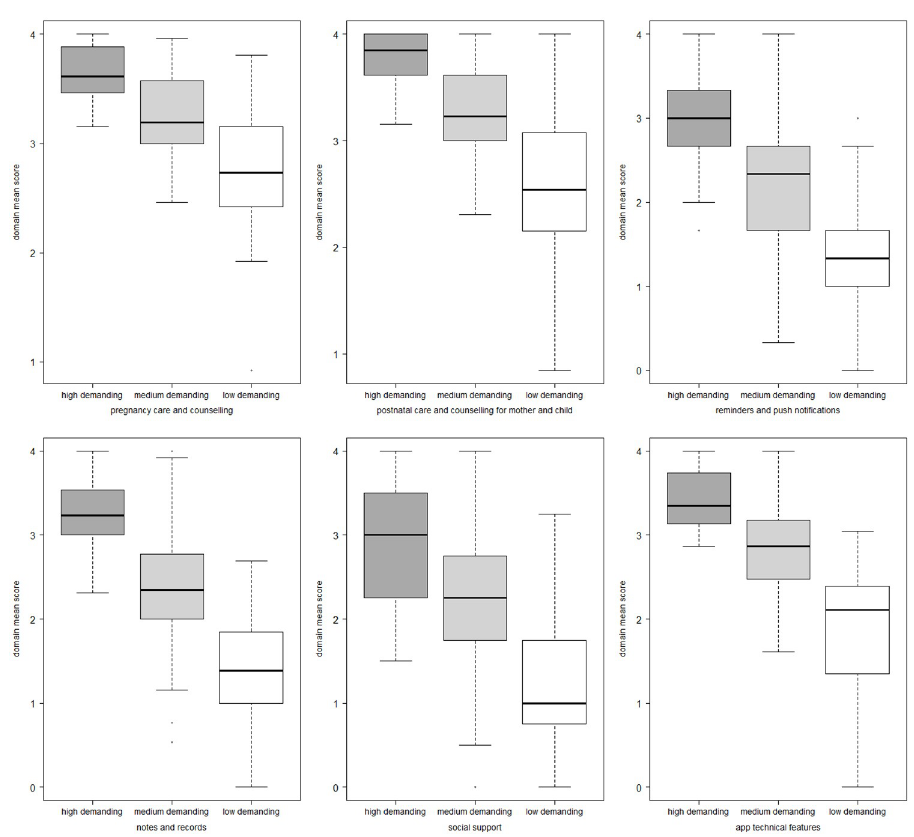
Fig 2. Distribution of health professionals’ responses by cluster (i.e., high, medium, and low demanding clusters) for each questionnaire domain.